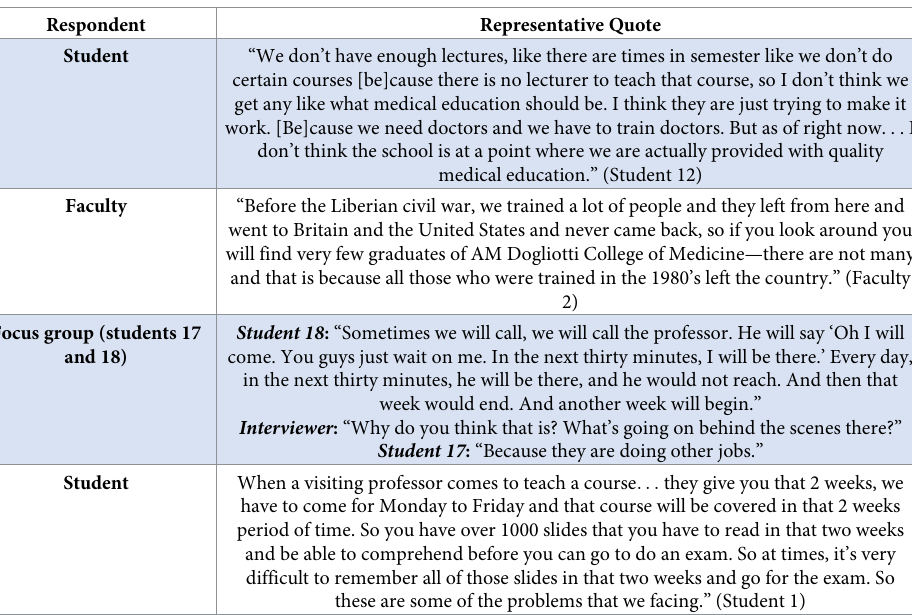
Table 1. Impact of faculty shortages on AMD student learning